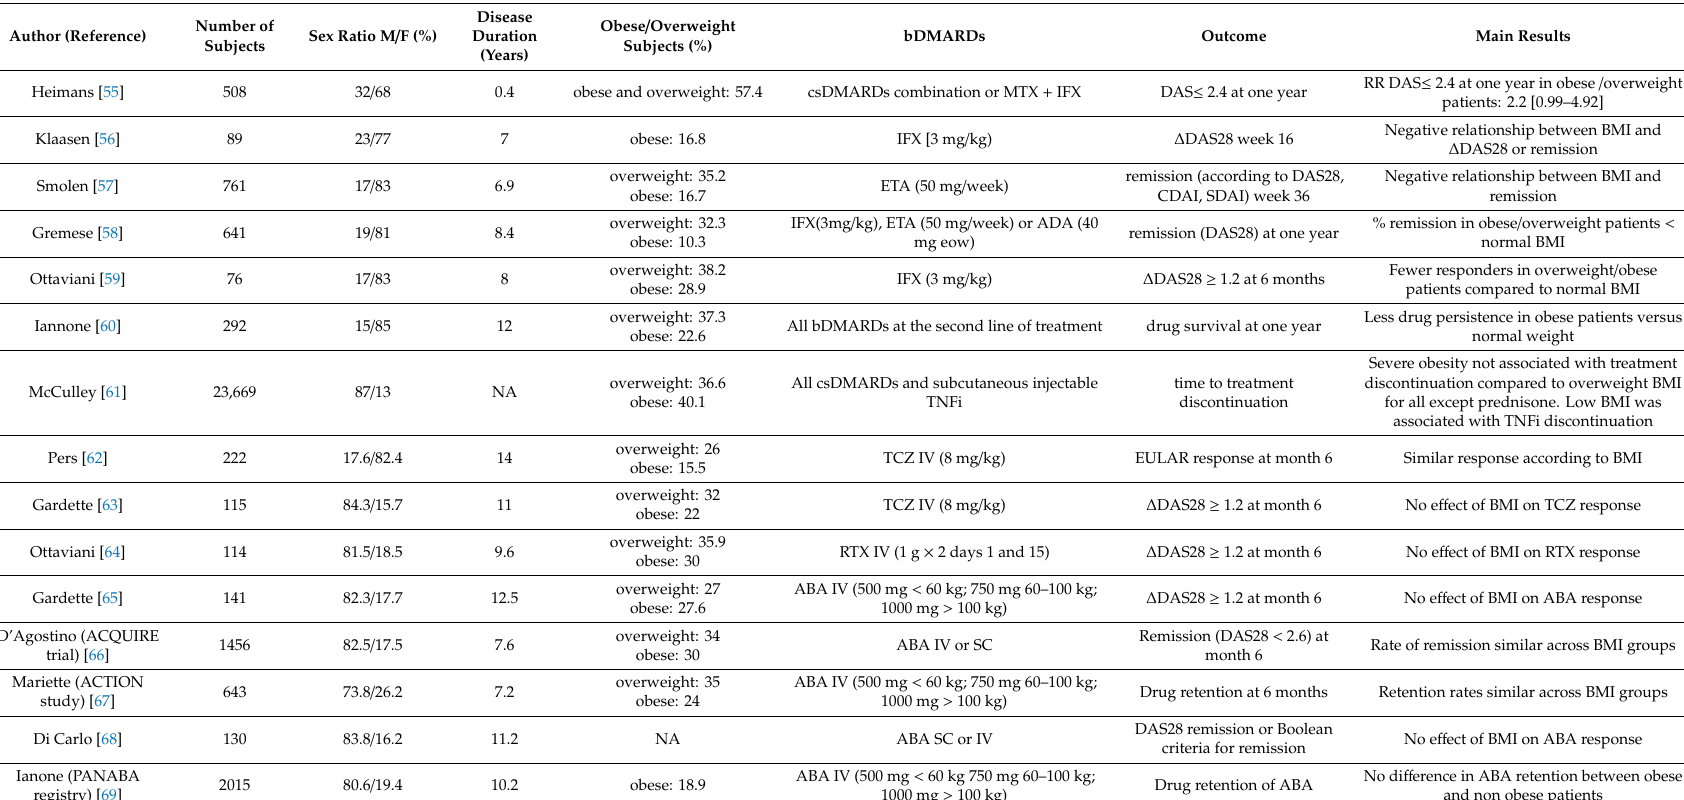
Table 3. Response to biological agents (bDMARDs) in obese / overweight patients with rheumatoid